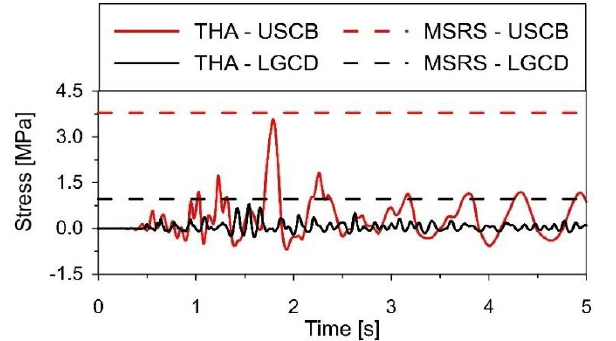
Figure 20. Comparison of the maximal principal stresses obtained for the mining-induced shocks from the USCB and the LGCD regions at point W4 based on the THA and the MSRS